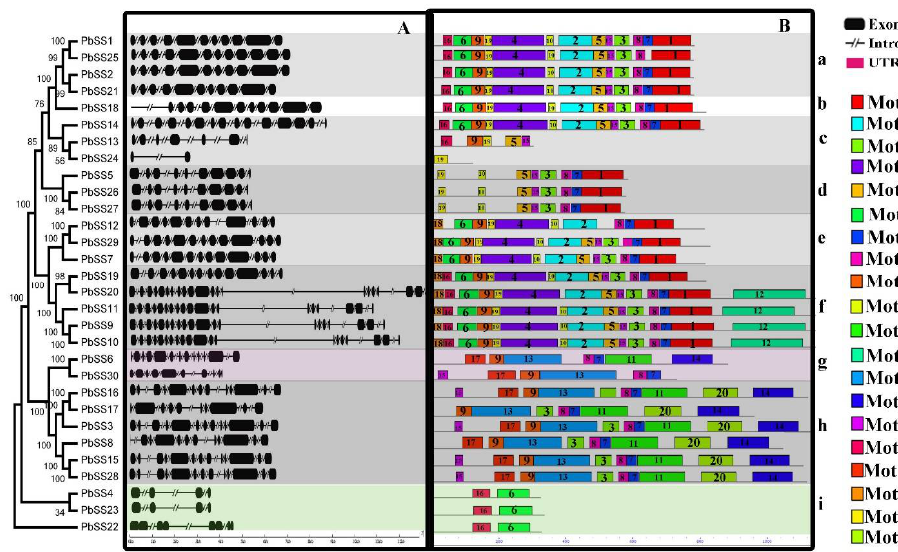
Figure 1. Gene structure and distribution of conserved motif of PbSSs genes in Chinese pear. ( A ) Phylogenetic relationship and gene structure of pear PbSSs genes. ( B ) Conserved motifs located on each gene with the relative combined p -value.